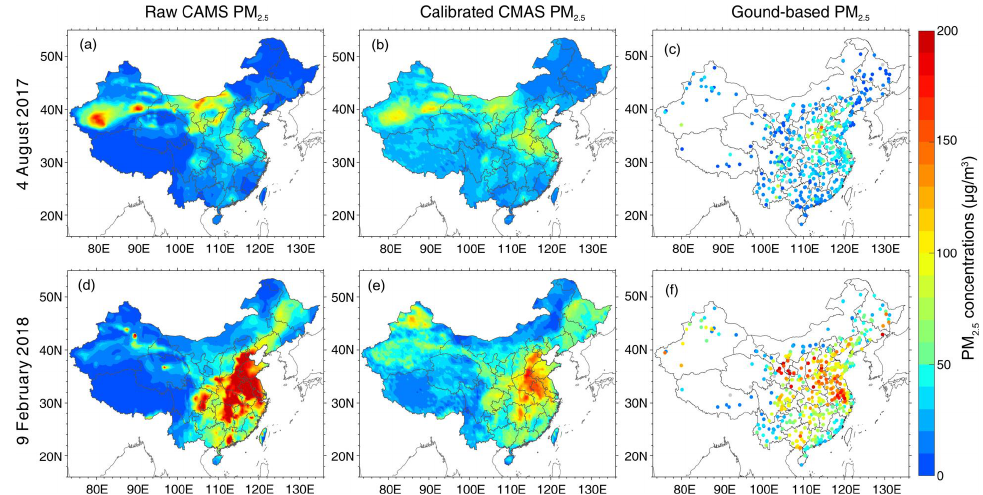
Figure 10. Comparisons of CMAS PM 2.5 forecasts with a forecasting time horizon of 3 h (step-3) before ( a , d ) and after ( b , e ) the calibration in China on two di ff erent days. ( c , f ) Show the in situ PM 2.5 measurements on the corresponding